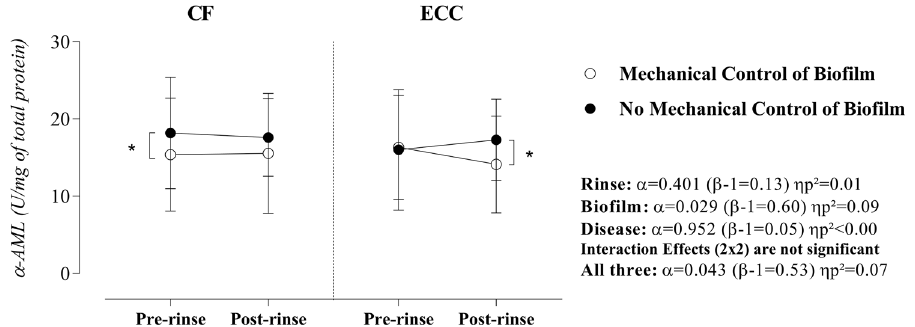
Figure 5. Effect of rinse, mechanical control of biofilm, and disease on salivary α-amylase. Statistical analyses were performed with a sample of 56 volunteers, 28 per group. ηp 2 : Partial eta squared. Data plotted as median and interquartile range (due to non-Gaussian distribution). To fulfill the ANOVA premises, we used the square root for data. Non-significant interactions were suppressed. A single asterisk represents a significant p-value ≤ 0.05. Simple effects for Rinse in CF children—Mechanical control of biofilm: α = 0.45 (β-1 = 0.12) ηp 2 = 0.01 and No mechanical control of biofilm: α = 0.74 (β-1 = 0.06) ηp 2 = 0.002. Simple effects for Rinse in children with ECC—Mechanical control of biofilm: α = 0.28 (β-1 = 0.19) ηp 2 = 0.02 and No mechanical control of biofilm: α = 0.03 (β-1 = 0.59) ηp 2 = 0.09. Simple effects for Biofilm in CF children—Pre-rinse: α = 0.04 (β-1 = 0.56) ηp 2 = 0.08 and Post-rinse: α = 0.09 (β-1 = 0.40) ηp 2 = 0.05. Simple effects for Biofilm in children with ECC—Pre- rinse: α = 0.42 (β-1 = 0.13) ηp 2 = 0.01 and Post-rinse: α = 0.04 (β-1 = 0.56) ηp 2 = 0.08. Simple Effects for